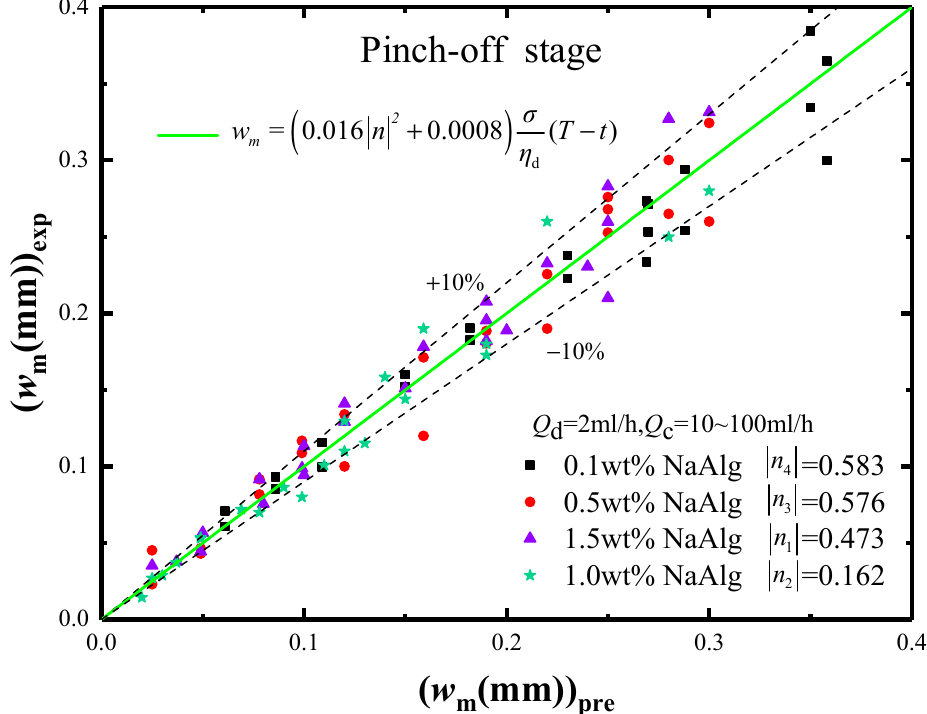
Figure 12. The accuracy analysis of w m prediction model in the pinch-off stage.